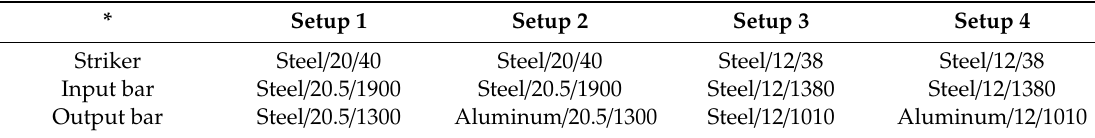
Table 8. Di ff erent material configurations for numerical SHPB test